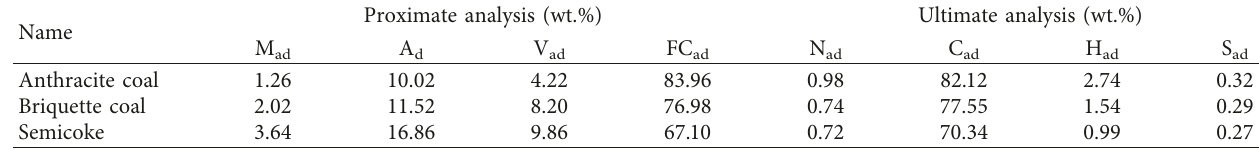
Table 2: Proximate and ultimate analysis of other samples. Proximate analysis (wt.%)